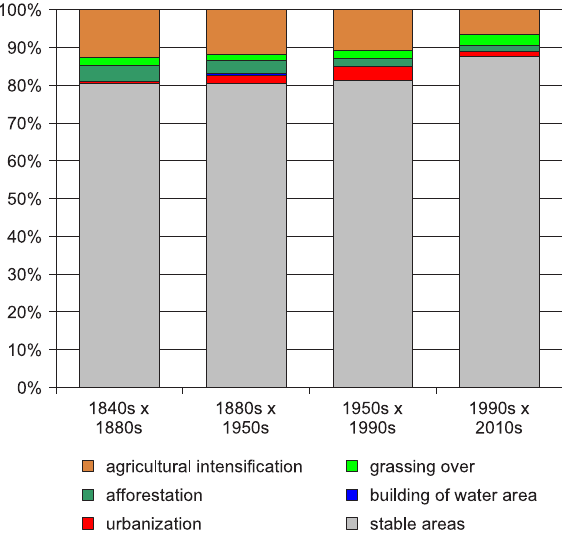
Fig. 7. land use change processes in the Hodonín region in four comparative